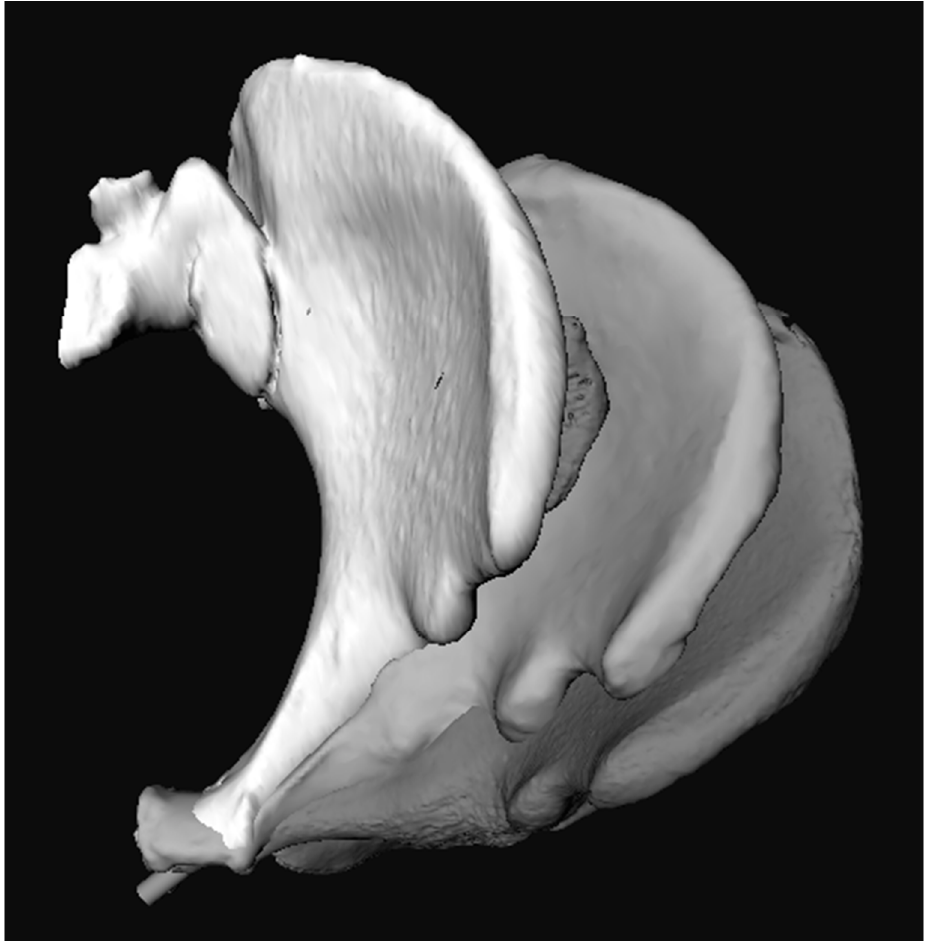
Figure 3. Inlet view of three segmentations of the hemipelvis. Matching was performed using Iterative Closest Point (ICP) or Procrustes analysis, which resulted in inadequate matches. The pubic bones seemed to match adequately, but the osseous fixation pathways (OFPs) diverted. The best results were gained after manually matching the models, especially when males and females were analysed separately (Figure 4).